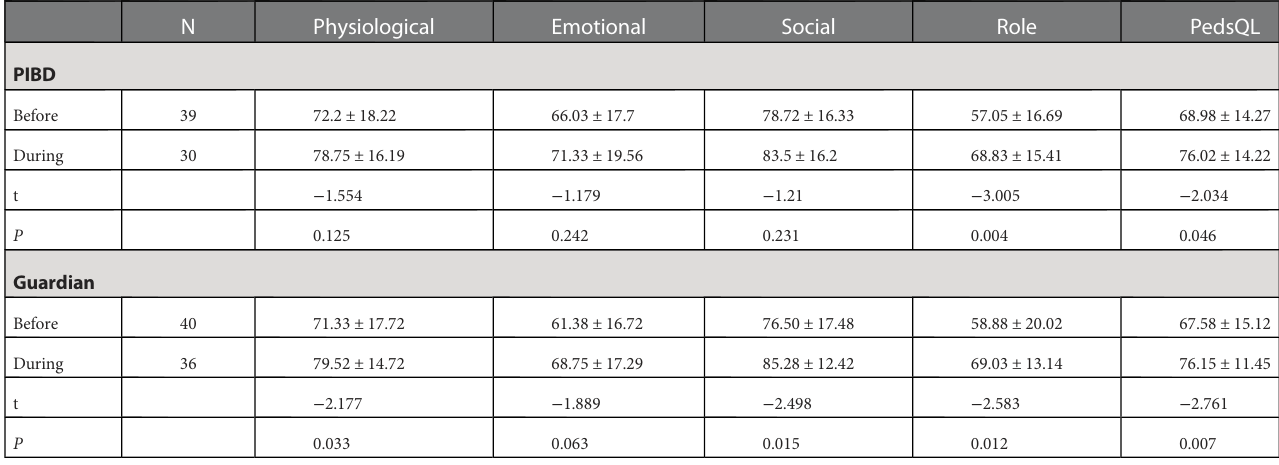
TABLE 2 The difference analysis of pedsQL 4.0 before and during